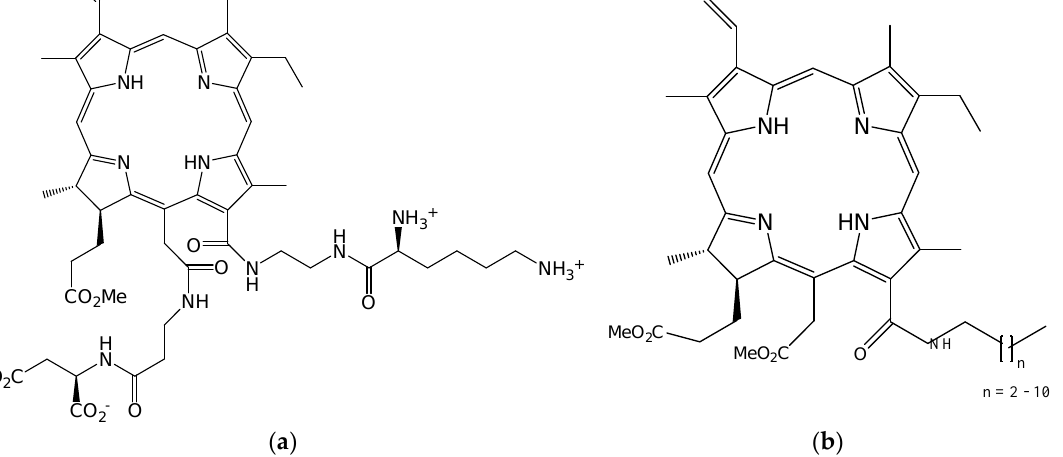
Figure 7. Structures of chlorin type macrocycles functionalized with lysine and aspartate fragments (a) [183] or hydrophobic amide groups (b) [184].